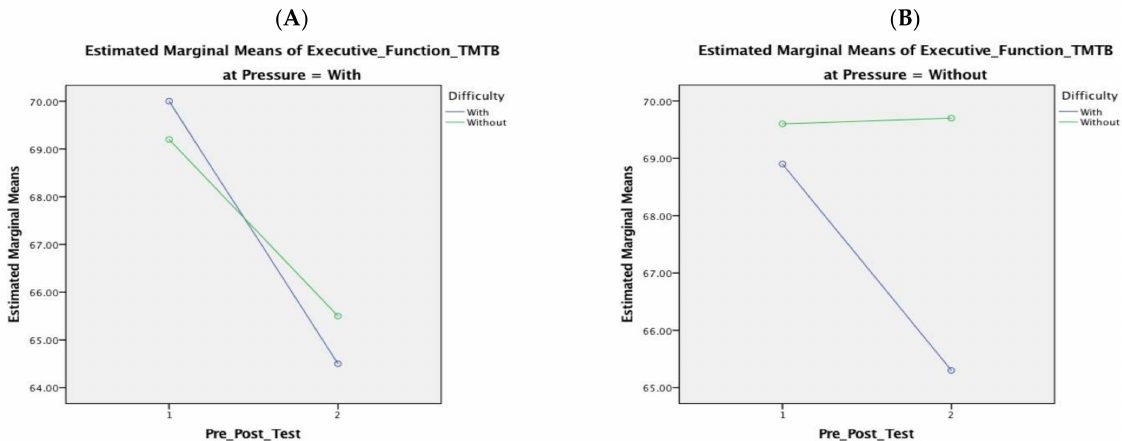
Figure 14. The graph of three-factor interaction in TMT-B. Figure ( A ) shows the interaction of pre/post-test * difficulty with pressure condition; Figure ( B ) shows the interaction of pre/post-test * difficulty without pressure condition. Note: pre/post-test (the horizontal axis), pre-test = 1, and post-test = 2.